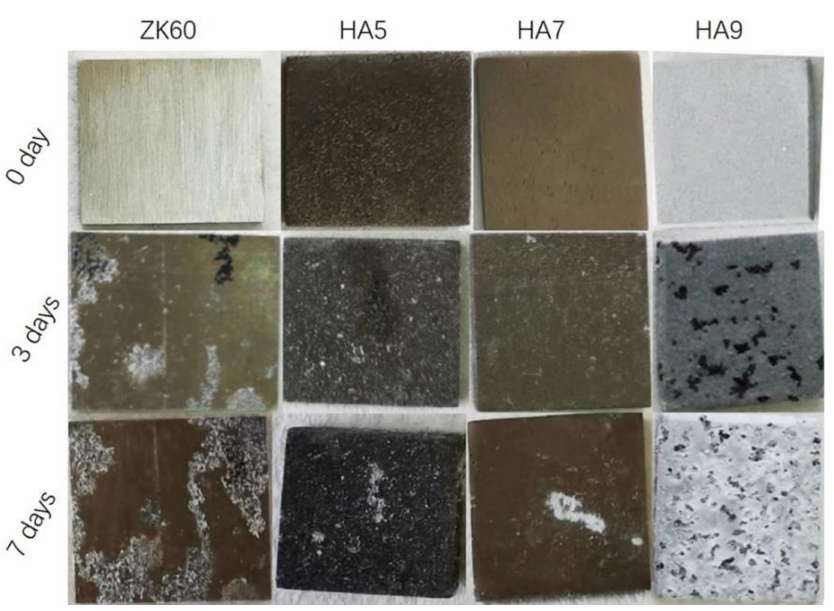
Figure 7. Optical images of the immersed